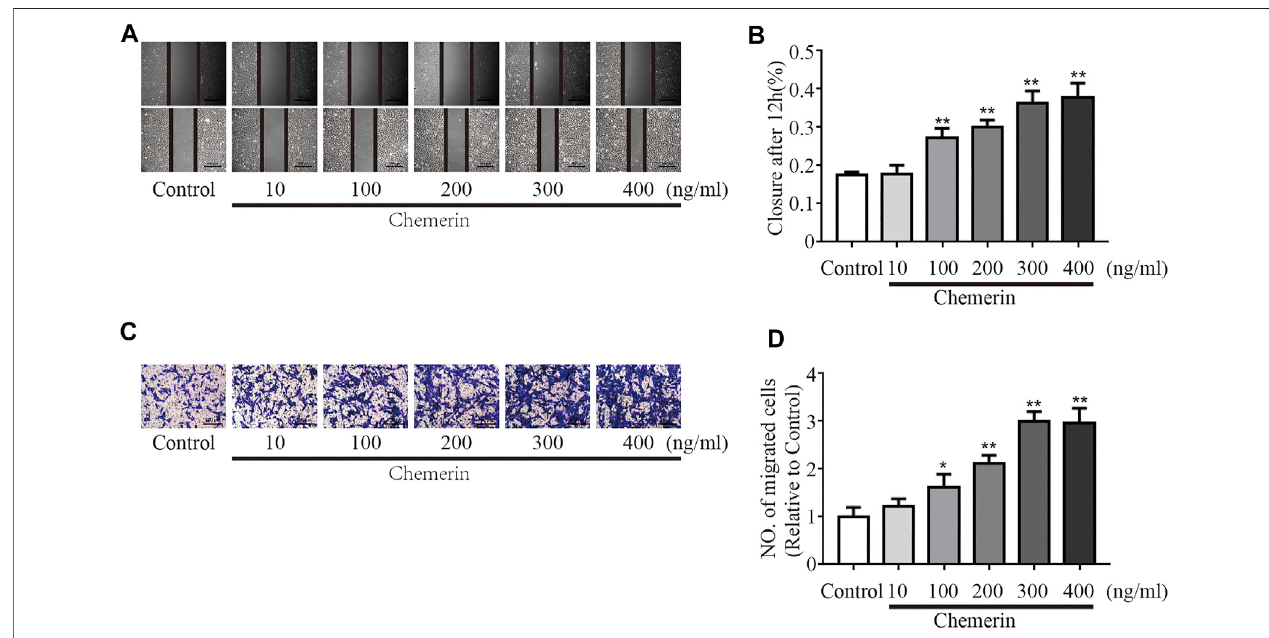
FIGURE 5 | Chemerin/CMKLR1 promotes the migration of PASMCs. PASMCs were stimulated with various concentrations of chemerin. (A – B) Images of scratches in PASMCs photographed at 0 and 12 h under different treatment conditions (original magni fi cation, × 50, scale bars, 500 μ m). (C – D) : Transwell migration assaysofPASMCs afterdifferenttreatments for12 h(originalmagni fi cation,×100,scalebars,200 μ m).* p < 0.05vs.thecontrolgroup;** p < 0.01vs.thecontrolgroup.